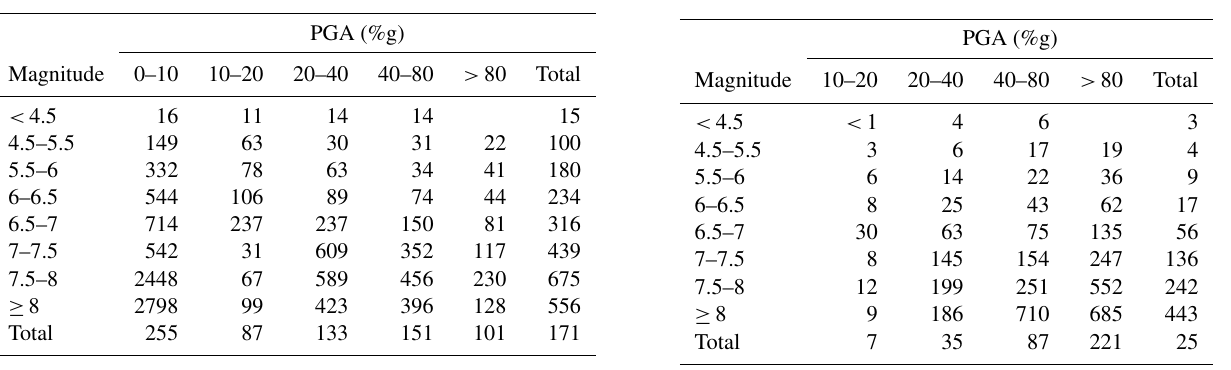
Table 2. Average area in square kilometers exposed to at least 90% of the maximum PGA, by magnitude and maximum PGA level.